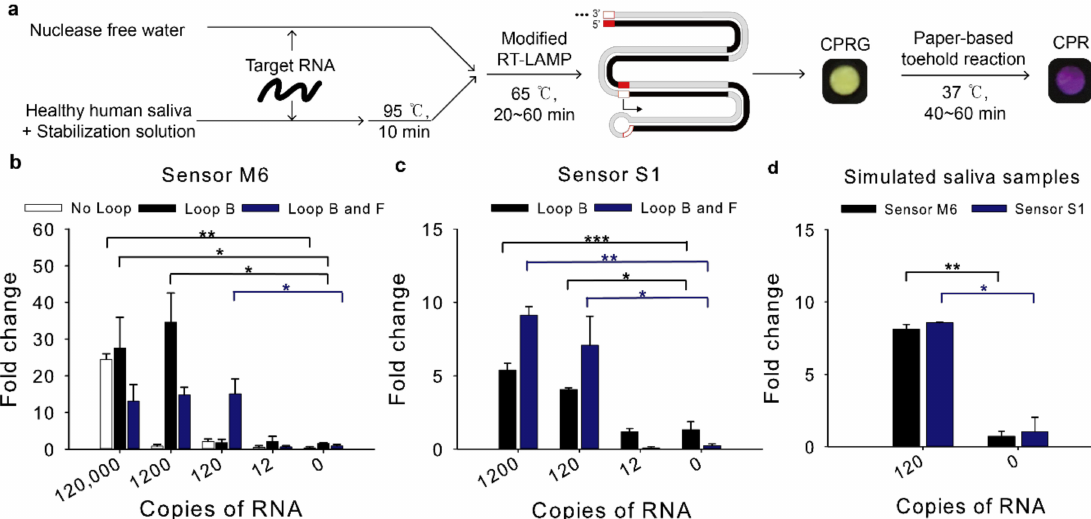
Figure 4. Detection limit of the modified RT-LAMP-coupled toehold reaction on contrived samples. The modified RT-LAMP is performed for 60 min with different combinations of loop primers (Loop B and Loop F). The resulting RT-LAMP product was applied to the subsequent toehold reaction. Fold change was calculated as the absorbance value from the toehold reaction with trigger RNA divided by that without the trigger RNA at 60 min. ( a ) Schematic illustration of the modified RT-LAMP and the subsequent toehold reaction. The paper assay image was the result of Figure 4d for sensor M6. ( b ) Effect of loop primers to improve detection limit of sensor M6. ( c ) Effect of different combinations of loop primers to detection limit of sensor S1. ( d ) Compatibility of human saliva with RT-LAMP-coupled toehold reaction. Loop B and Loop F were used for sensor M6 and S1. Two-tailed student’s test; * p < 0.05, ** p < 0.01, *** p < 0.001; Error bars represent ± s.d., n =